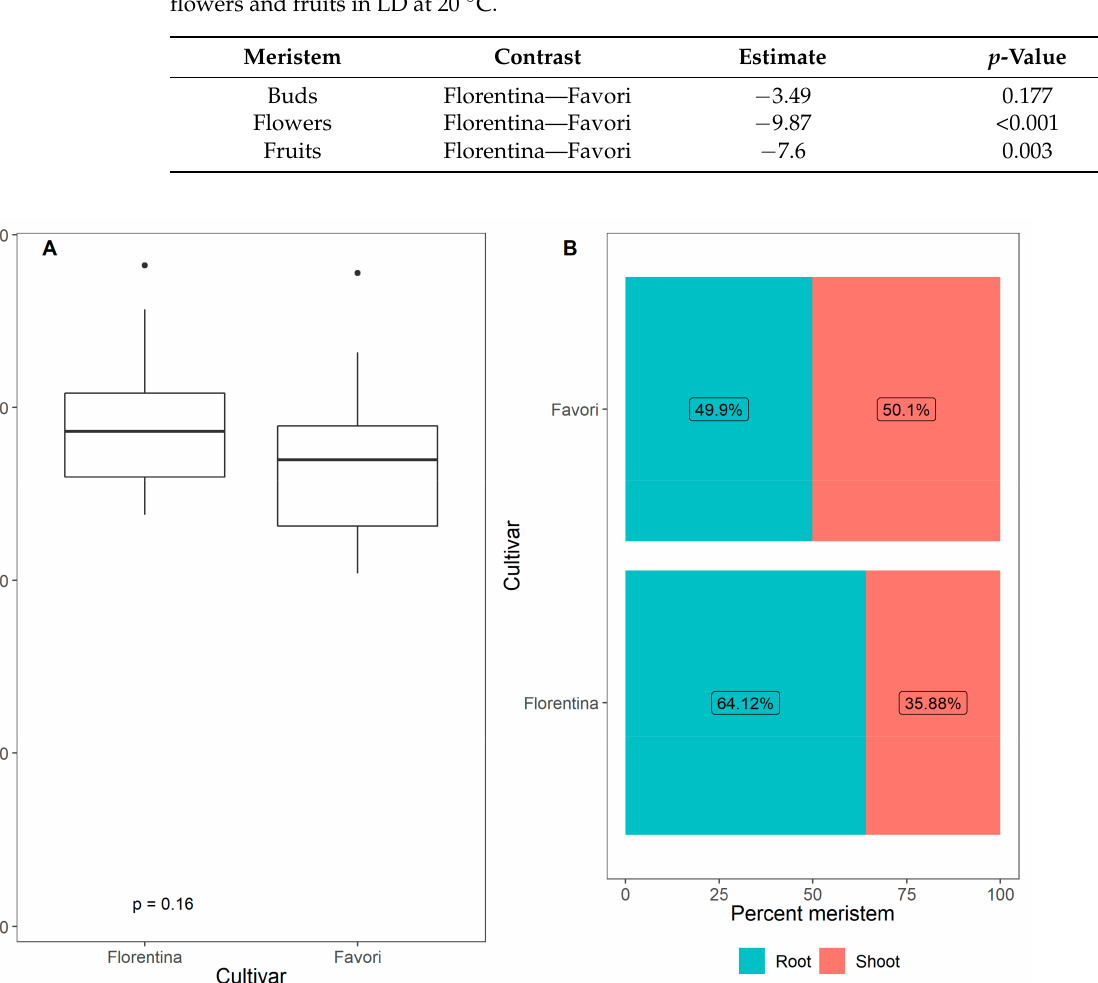
Table A9. Pairwise comparison of ‘Florentina’ and ‘Favori’ for the differentiation of meristem into flowers and fruits in LD at 20 ◦ C.